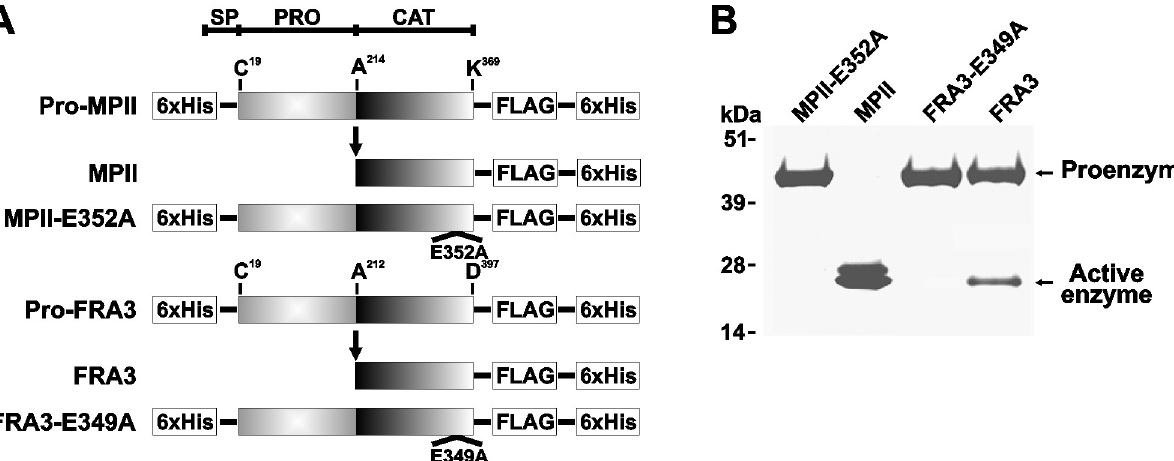
Fig 1. MPII and FRA3 recombinant constructs (alternative version provided by the corresponding author). A , the arrow indicates the position of self-conversion of the proenzyme into the fully active enzyme. The constructs were tagged with the Hisx6 and FLAG tags. E349A and E352A indicate the base substitution sites that transform the wild-type FRA3 and MPII into the catalytically inactive constructs of FRA3 and MPII, respectively. As a result of these inactivating mutations, Ala substitutes for the essential active site Glu residue. SP, signal peptide; PRO, prodomain; CAT, catalytic domain. B , SDS-gel electrophoresis of the purified MPII and FRA3 constructs followed by Coomassie staining.